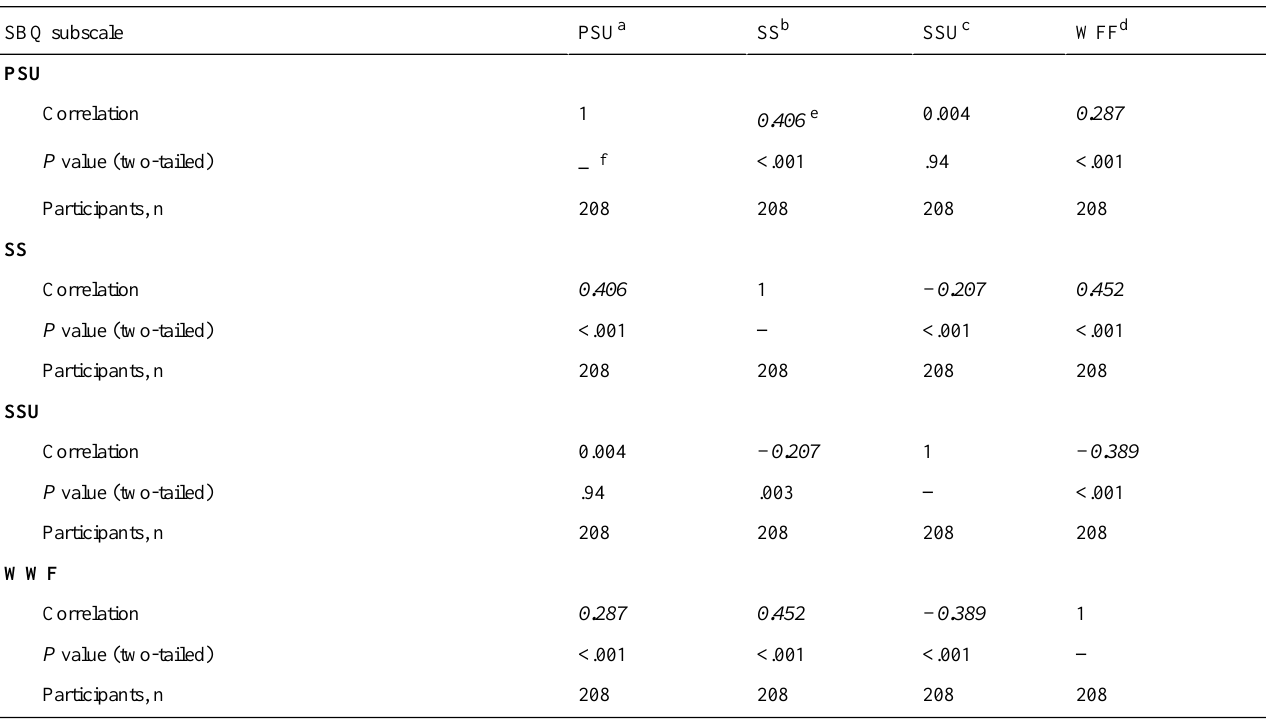
Table 4. Significant Other Behavior Questionnaire subscale